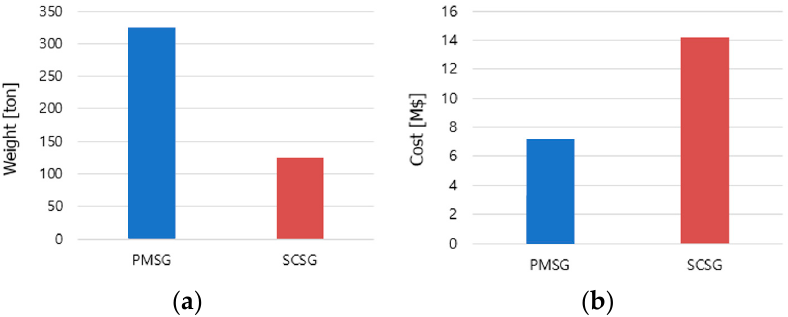
Figure 3. Comparison of the PMSG and SCSG; ( a ) weight of the PMSG and SCSG and ( b ) cost of the PMSG and SCSG.